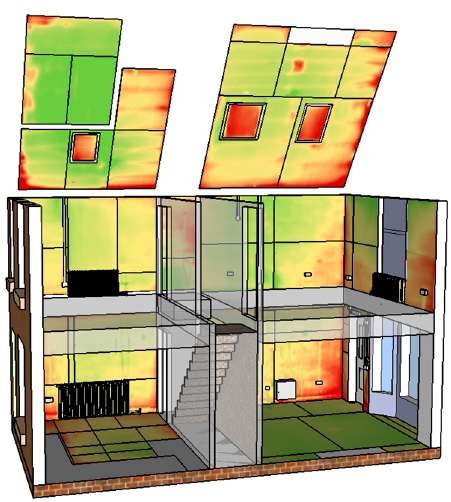
Figure 6. Visualisation of the U-value distribution for components of the Energy House’s envelope, generated using high-resolution infrared thermography (IRT).